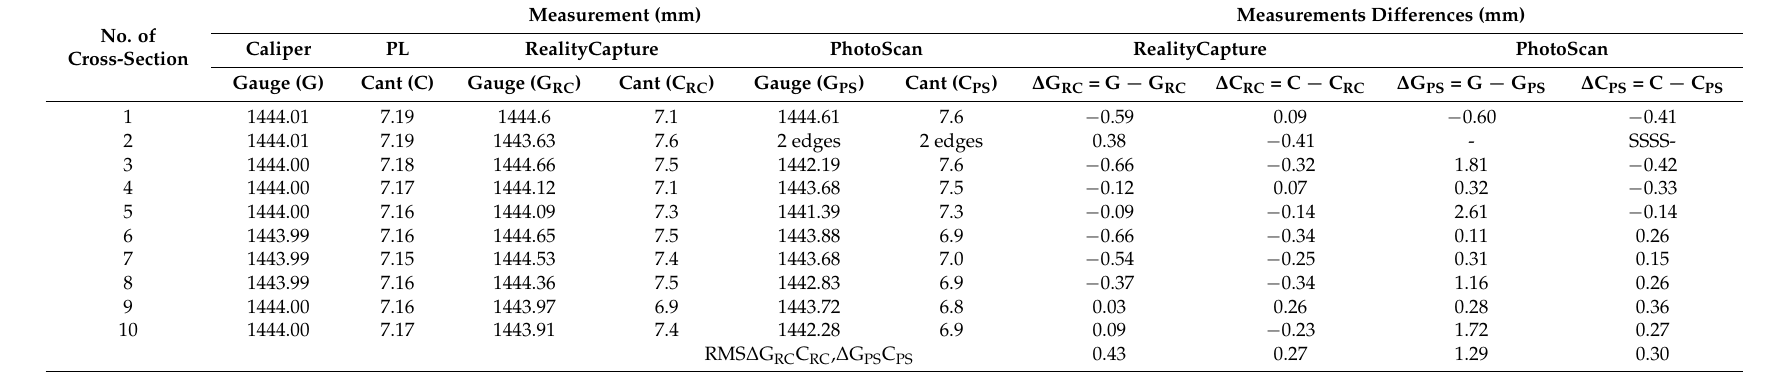
Table 2. Track gauge (G) and cant (C) measurements results on the 3D rail track basic